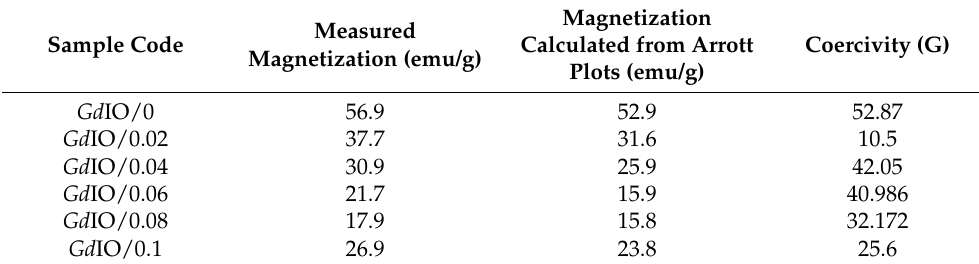
Figure 7. Arrott plots for samples Gd O/0, Gd IO/0.02, Gd IO/0.04, Gd IO/0.06, Gd IO/0.08 and Gd IO/0.1 from left to right. Table 2. Magnetization and coercivity values for samples Gd IO/0, Gd IO/0.02, Gd IO/0.04, GdIO/0.06, Gd IO/0.08 and Gd